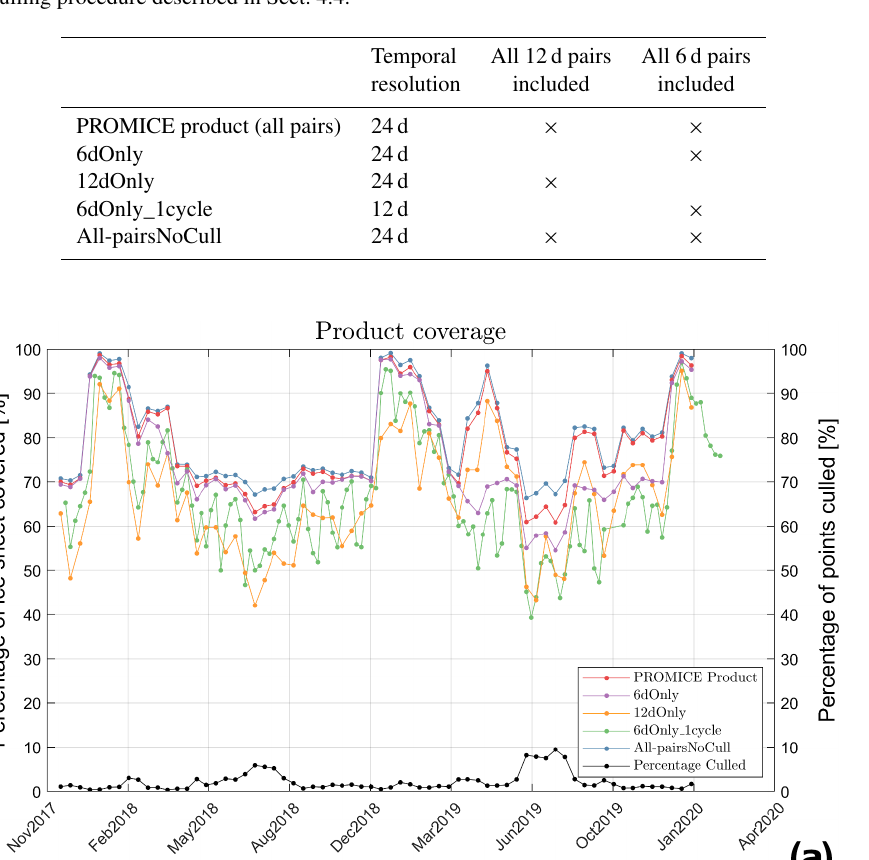
Table 4. Information on time series of mosaics from Sentinel-1 data. All-pairsNoCull contains the same data as the PROMICE product but has not undergone the culling procedure described in Sect. 4.4.